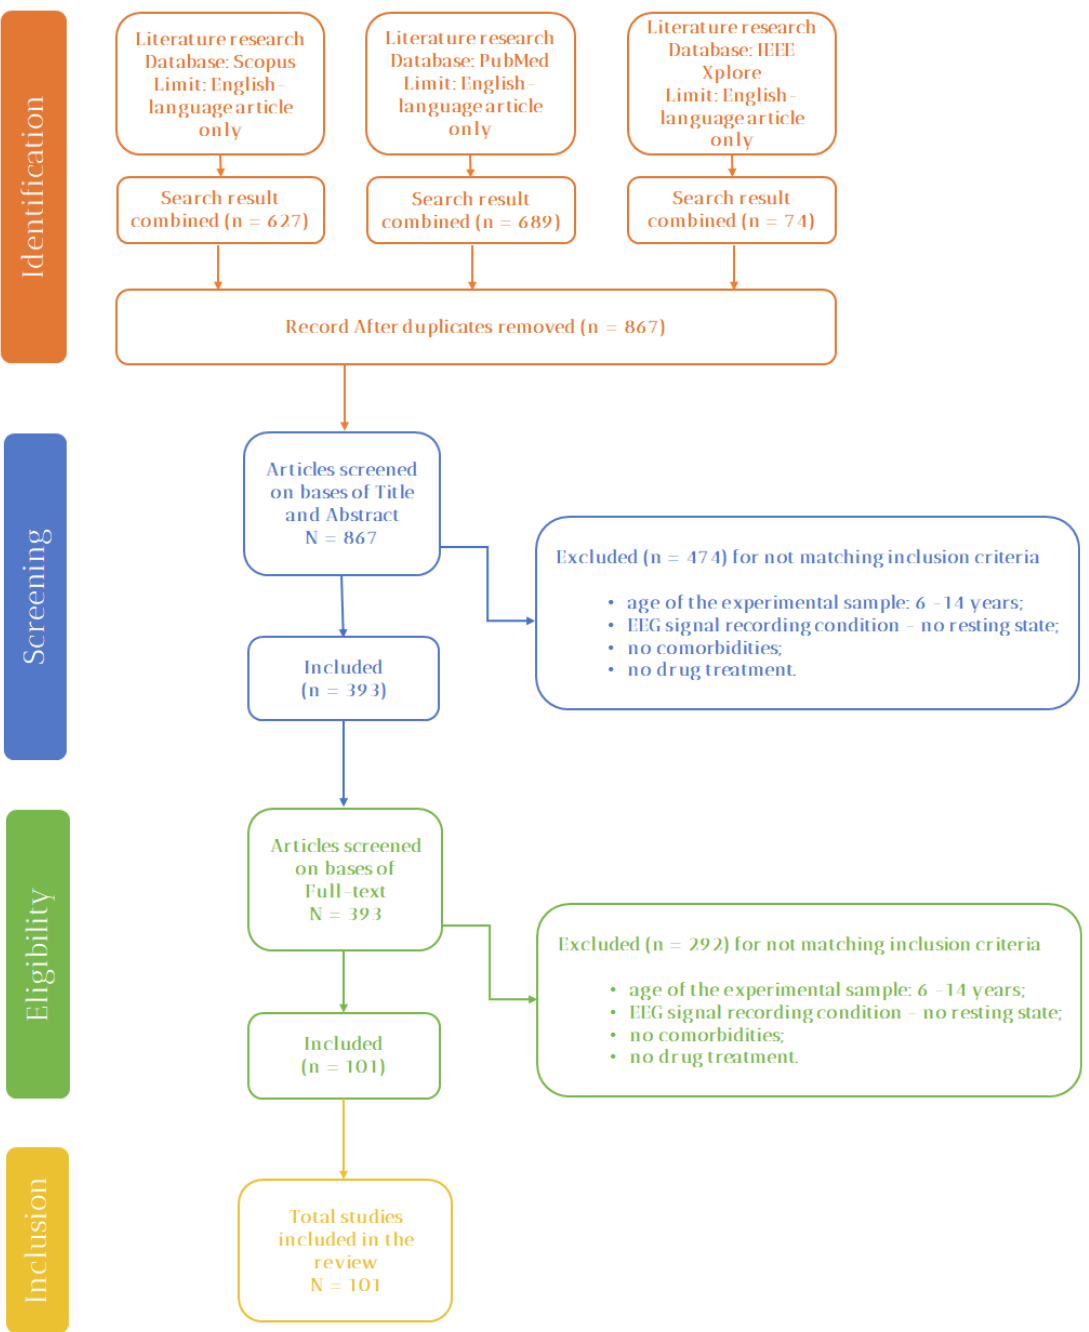
Figure 1. PRISMA-flow of the articles selection